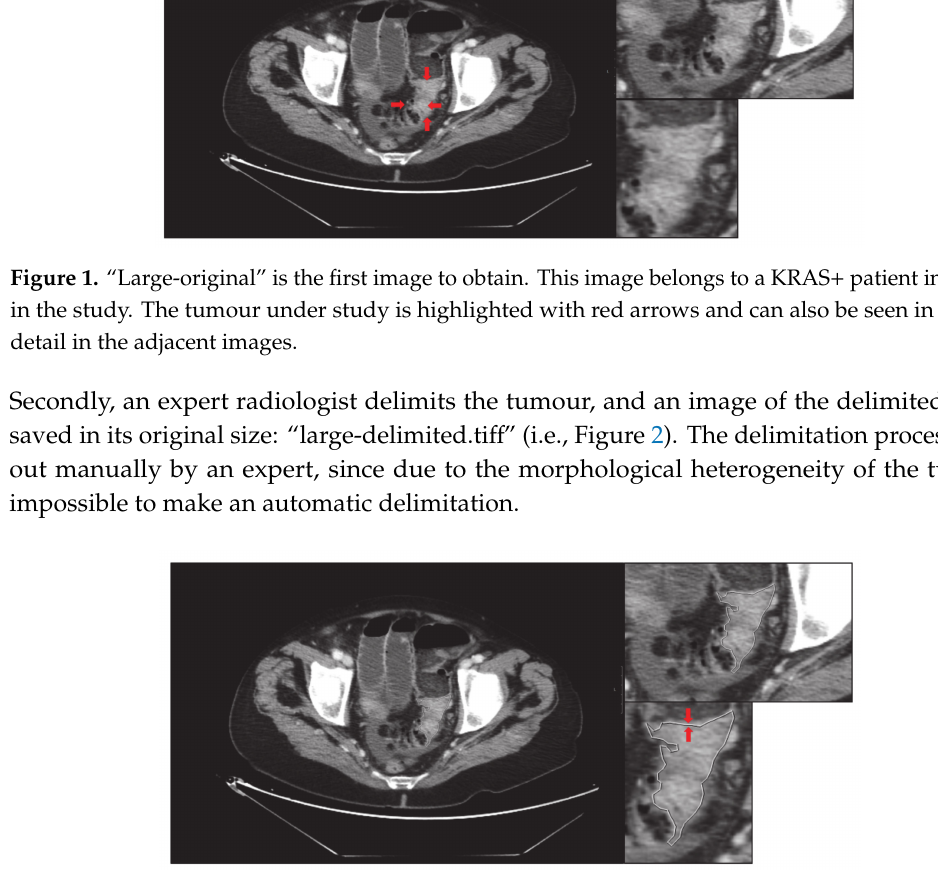
Figure 2. “Large-delimited” is the second image to be obtained. In the two adjacent small images, the delimited tumour can be seen in detail. The delimitation line is highlighted between the two red arrows in the most enlarged